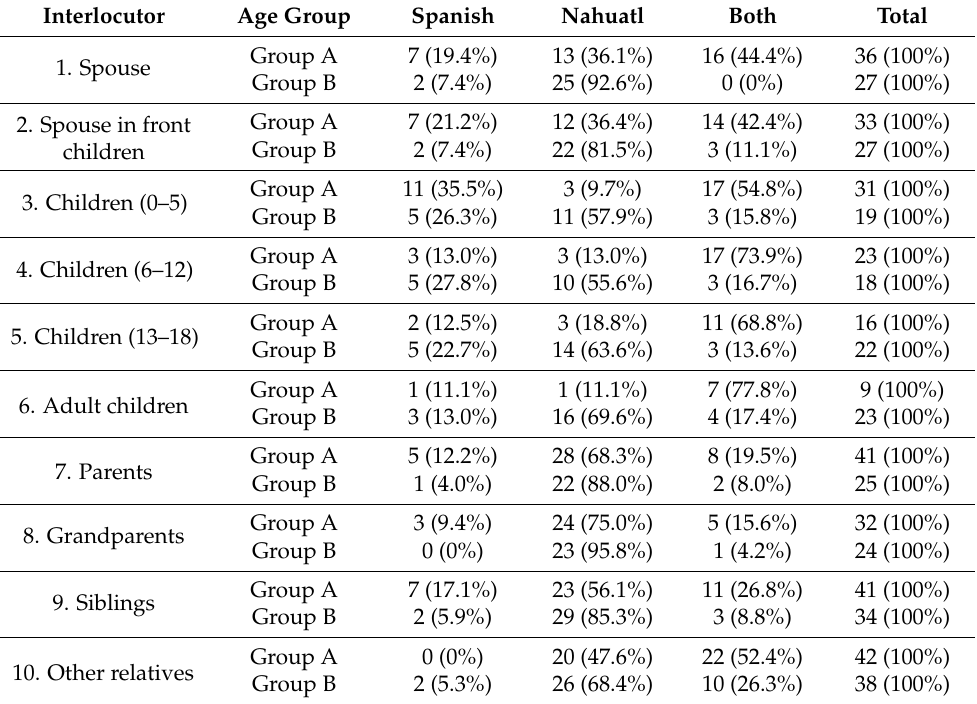
Table 2. Home language use by age group.